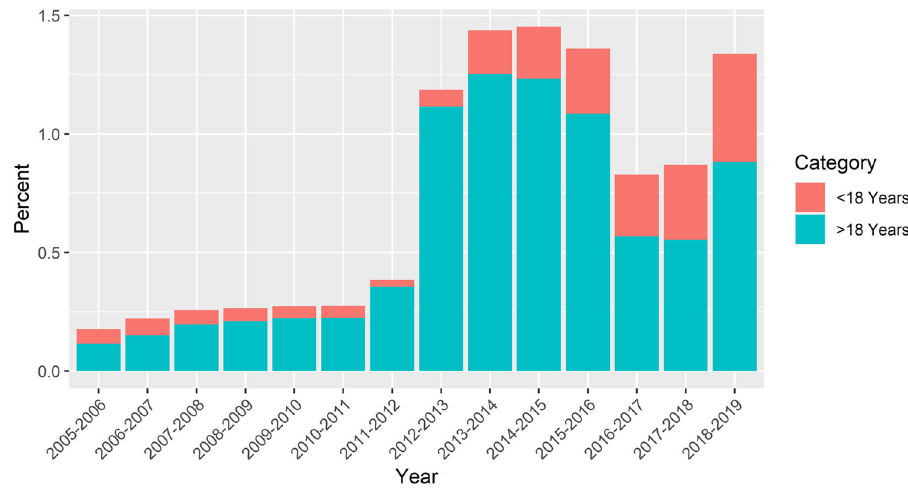
Fig. 1 Qur'an course attendance from 2005-6 to 2018-9 education year. Population share of students in Qur'an courses. Red bars represent those younger than 18 years while blue bars represent those older than 18 years.